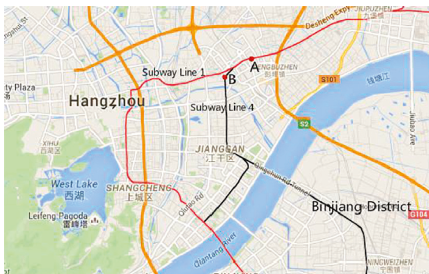
Figure 1: Location of the new tunnels and the existing tunnel in Hangzhou. A: Guanhe Station; B: East railway station.